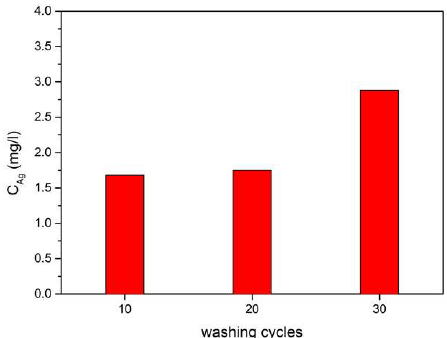
Figure 5. Atomic absorption spectrometry (ASA) of solutions obtained after home laundry washing of cellulose fibers containing 3 wt % AgNPs.